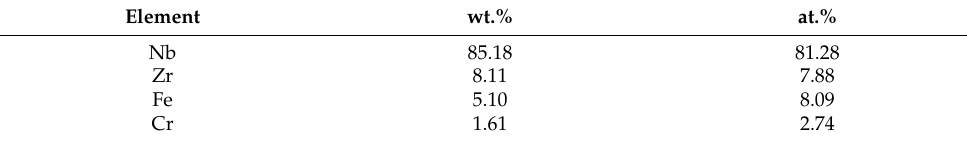
Table 2. Element contents of Nb-Zr alloying layer prepared at a pressure of 40 Pa.